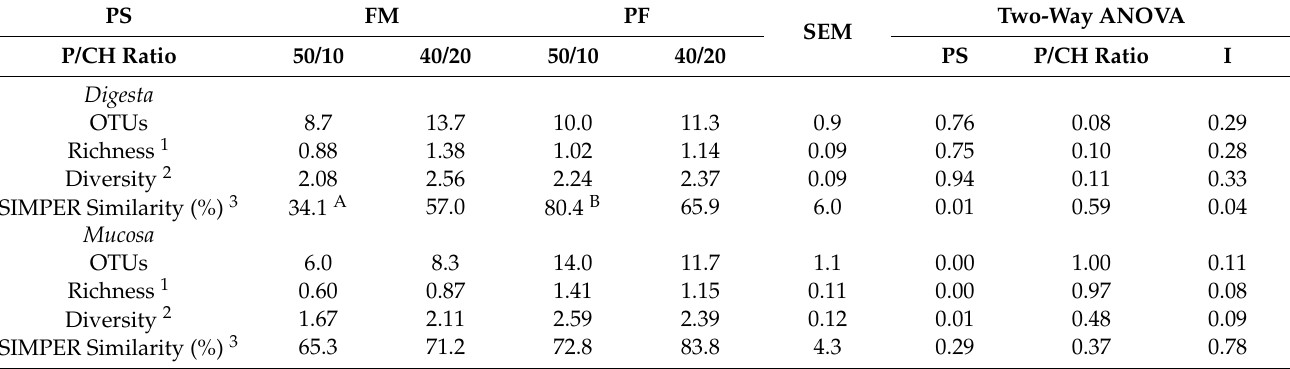
the table. CH: carbohydrate; FM: fishmeal; I: interaction; OTUs: average number of operational taxonomic units; PF: plant feedstuffs; P: protein; PS: protein source. 1 Margalef species richness: d = (S − 1)/log(N). 2